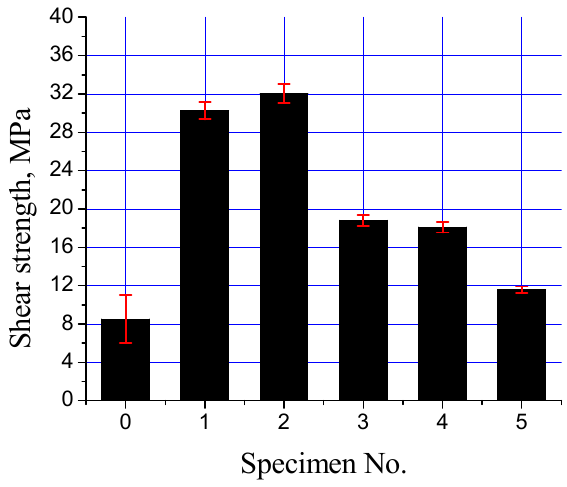
Specimen No. Figure 13. Interfacial shear strength of mild steel/Al-bearing alloy composites (S0 to S5). Table 5. Reports on the shear property of Al/Fe bimetallic composites for different interlay materials and deposition processes in the various interlayer materials and casting processes. The Sn and Sn + 0.25%Al 2 O 3 nanopar-